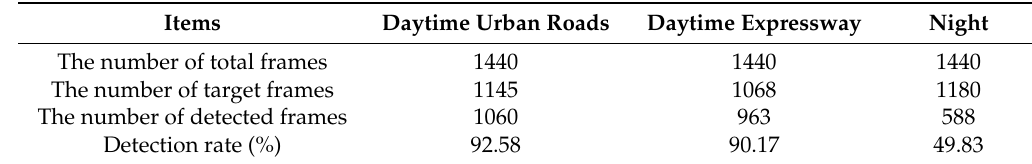
Table 2. The vehicle detection rate according to the driving environment.